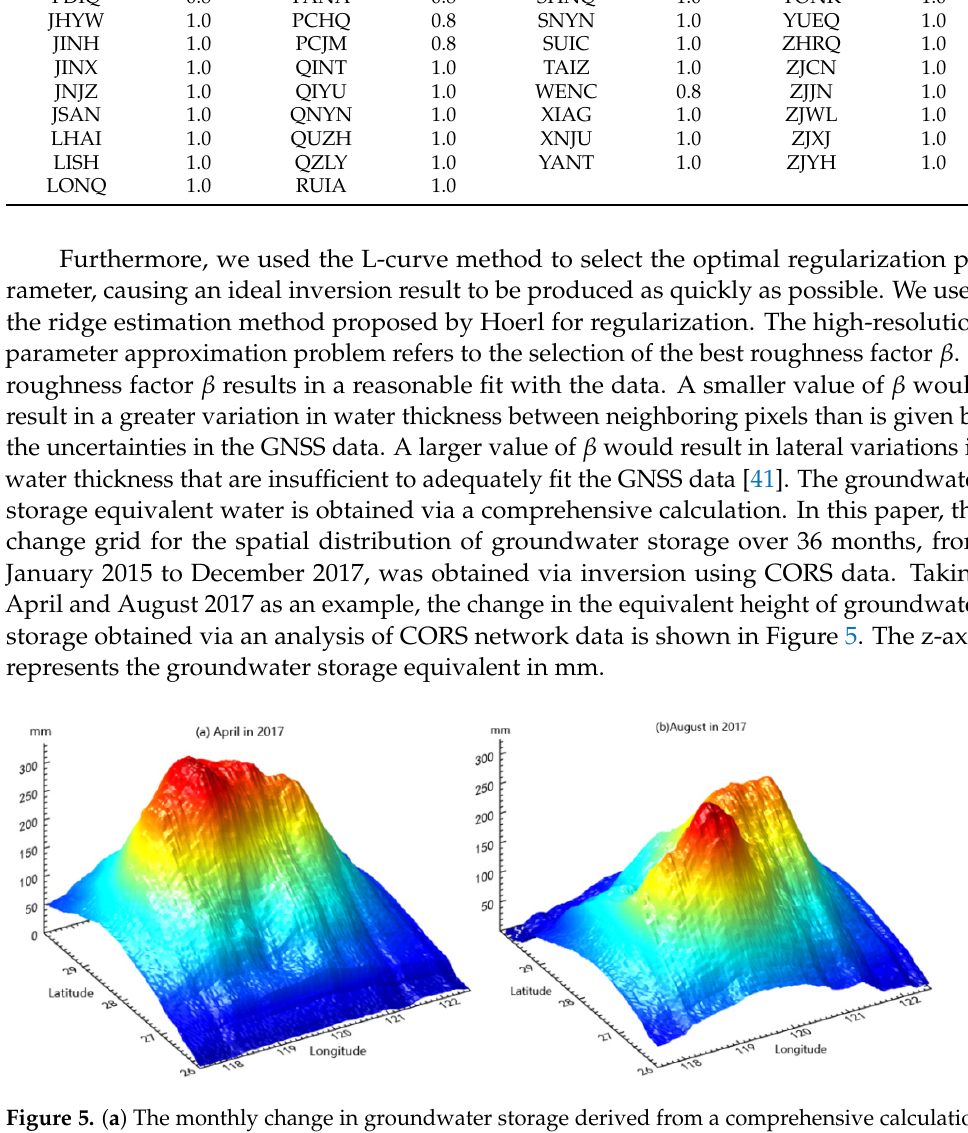
Table 3. The weights 38 CORS in the study area.